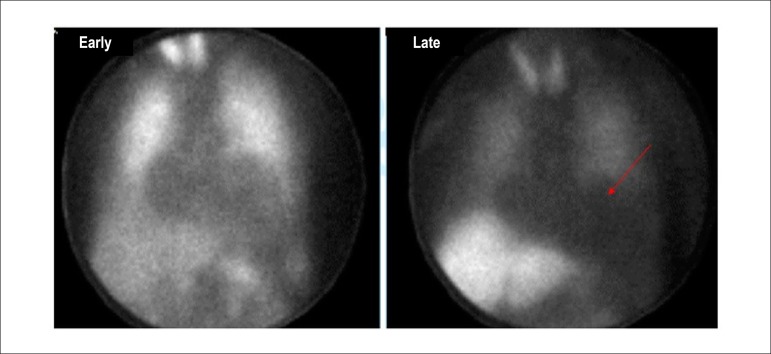
Abnormal cardiac scintigraphy with MIBG-123I of a patient with advanced heart failure and highly reduced radiopharmaceutical uptake in the cardiac area (arrow), which denotes cardiac sympathetic hyperactivity. Black and white images of the anterior thorax, acquired approximately 15 minutes (early) and 4 hours (late) following intravenous injection of the radiopharmaceutical MIBG-123I.